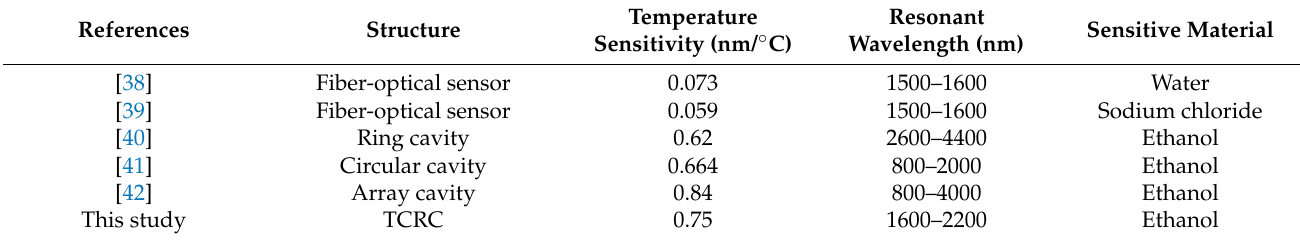
Figure 8. ( a ) Transmission spectrum at different temperatures. ( b ) Temperature sensitivity fitting curve. Table 2. The temperature sensitivity reported in references.